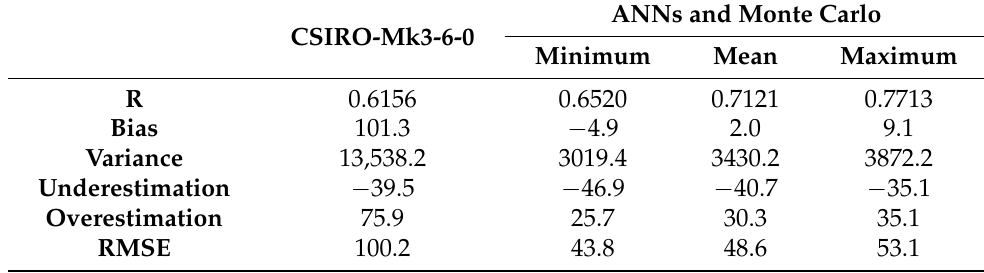
Table 4. Comparison of average efficiency coefficients of CSIRO-Mk3-6-0 model and Monte Carlo downscaling for rainfall.